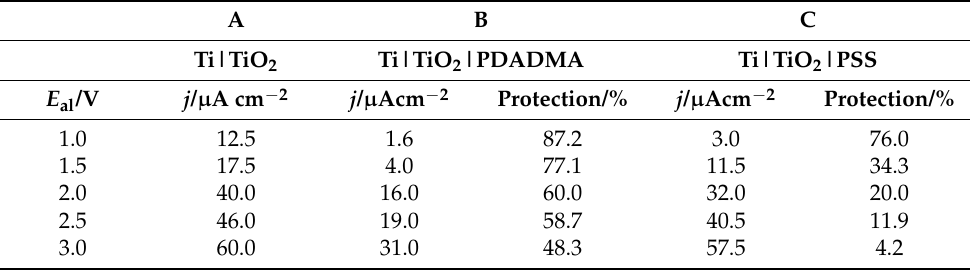
Table 2. Corrosion protection level of polyelectrolyte modified Ti substrates (Ti|TiO 2 |PSS and Ti|TiO 2